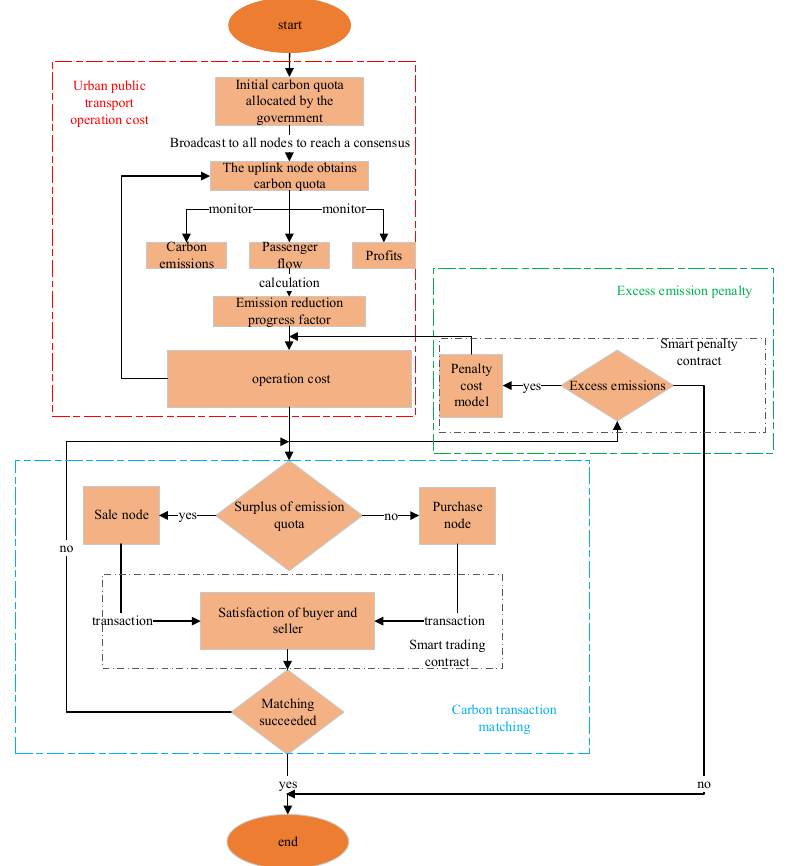
Figure 2. Flow chart of urban public transport carbon-trading system based on blockchain technol- ogy.